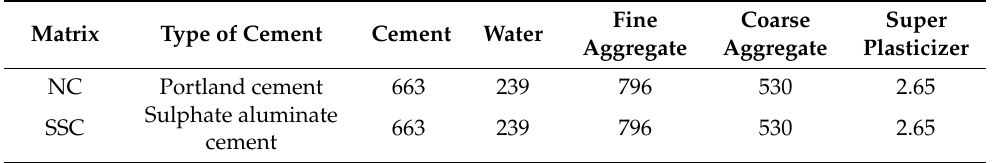
Table 1. Mixture ratio of concrete (kg/m 3 ).